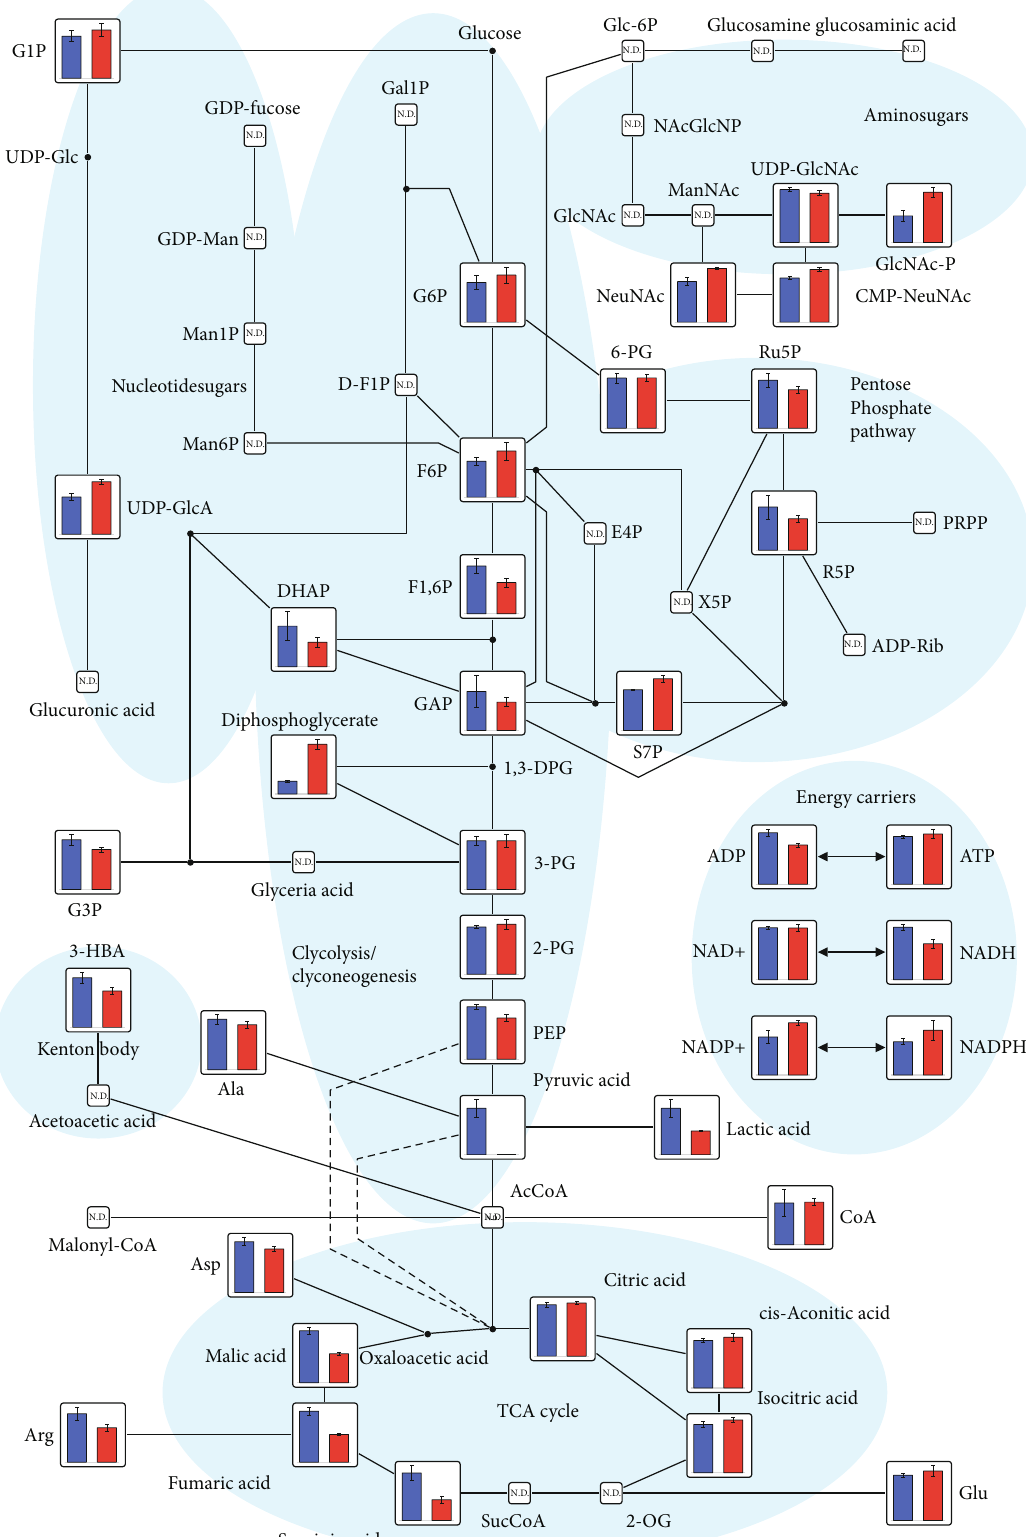
Figure 2: Map of central carbon metabolism pathways. Metabolites involved in the glycolysis/glyconeogenesis, TCA cycle, and central carbon metabolism are highlighted in the map. Blue bar: control (no treatment); Red bar: NH mean ± SD . n = 3